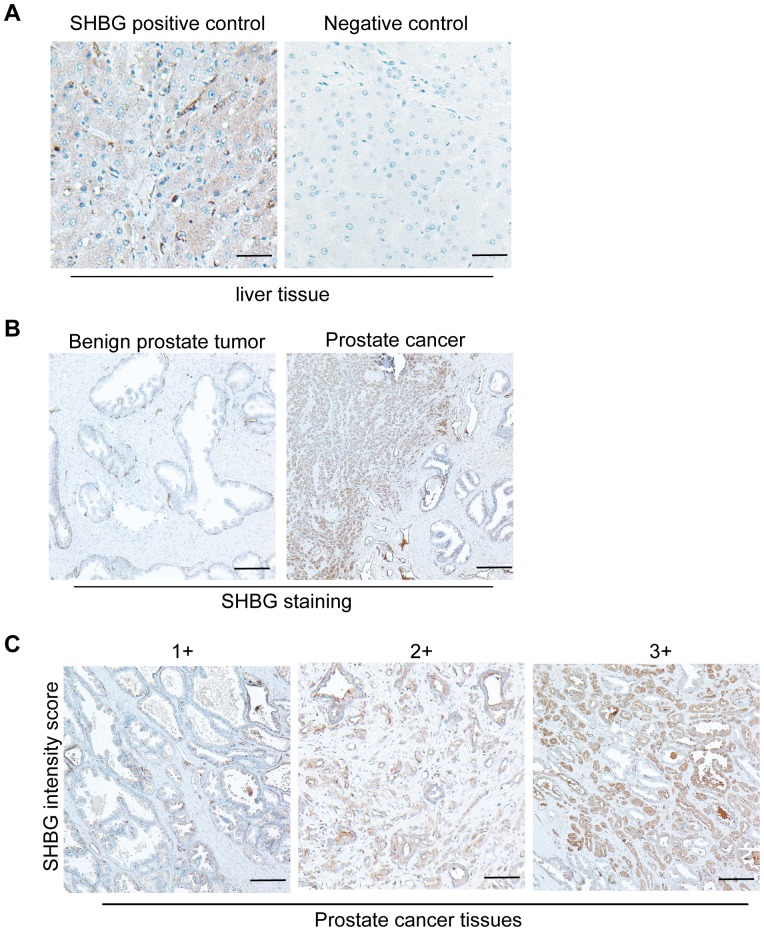
Immunohistochemistry of SHBG expression in prostate cancer tissues.(A) Positive and negative control of SHBG in liver tissues. (B) Weak SHBG positivity is shown in a benign prostate tumor and strong SHBG immunoreactivity is revealed in a malignant Gleason score 8 cancer tissue. (C) Representative immunohistochemical images of different scores of prostate cancer samples are shown. Bar scale in all of the images is 150 µm.